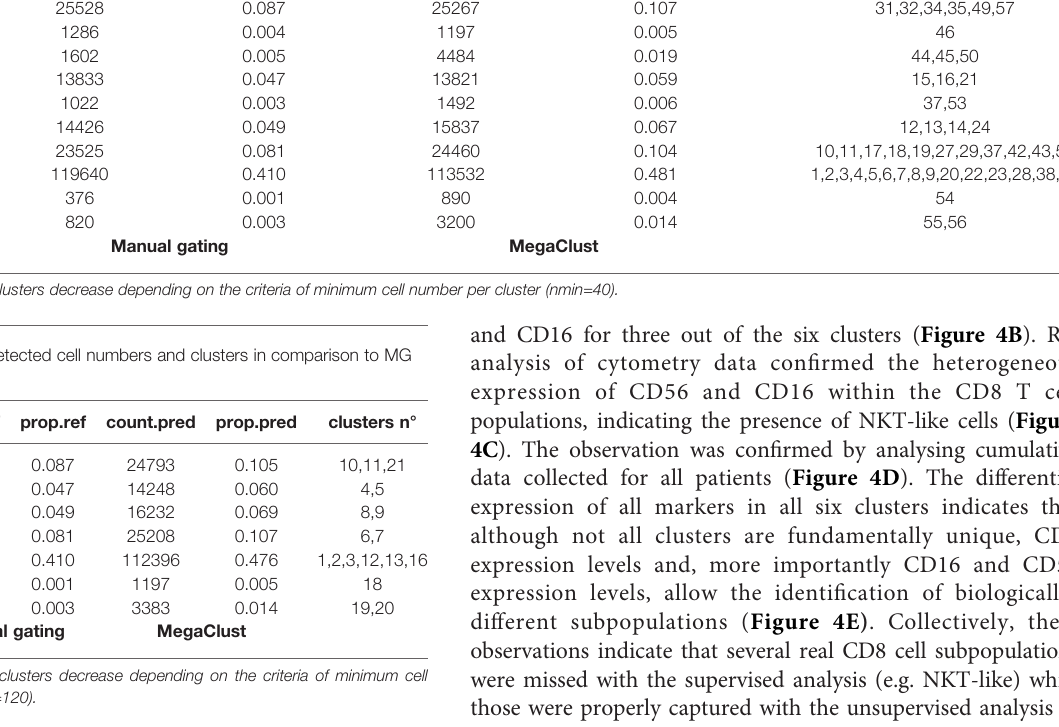
TABLE 1A | Table of detected cell numbers and clusters in comparison to MG populations. population count.ref prop.ref